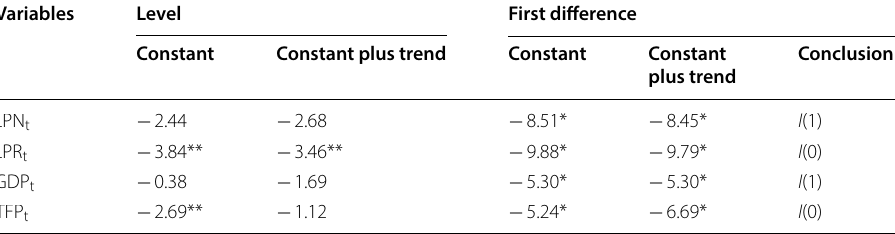
Table 4 Unit root